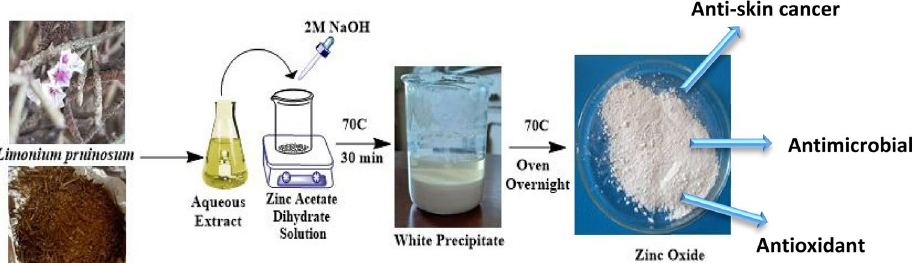
Figure 1. Schematic illustration of the phytosynthesis of ZnO